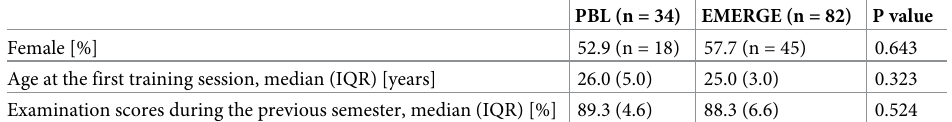
Table 1. Participant characteristics. P values were derived from a Mann-Whitney-U-Test.